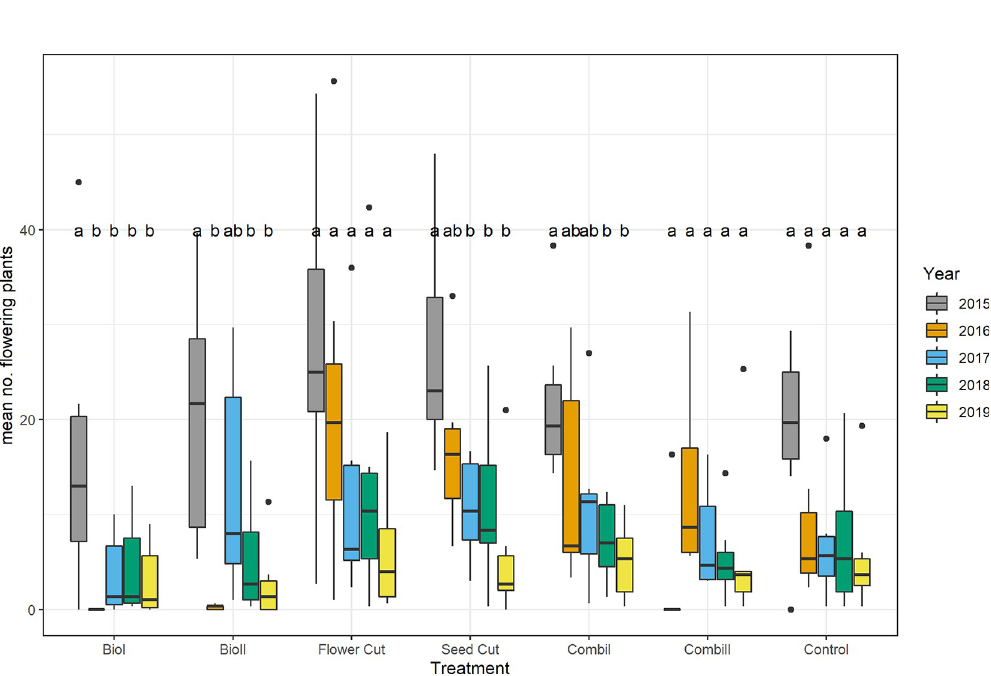
Fig 4. Abundance of flowering J . vulgaris plants per one square meter according to treatment and year. In the box plots, the middle lines represent the median, boxes represent the first and third quartiles, lower and upper bars represent the minimum and the maximum, and points represent outliers (i.e. points above 1.5 SD). Different letters indicate significant differences between the years within the treatments (TukeyHSD, P � 0.05).